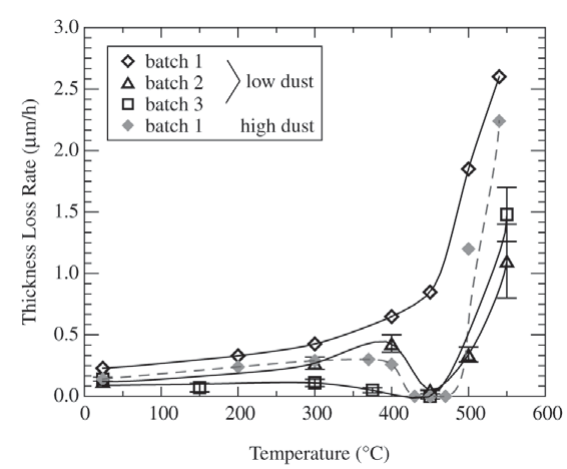
Figure 3. Maximum wastage rates as a function of specimen tem- perature. Three batches of sand were used, with increasing con- centrations of K, Ca, and Al containing